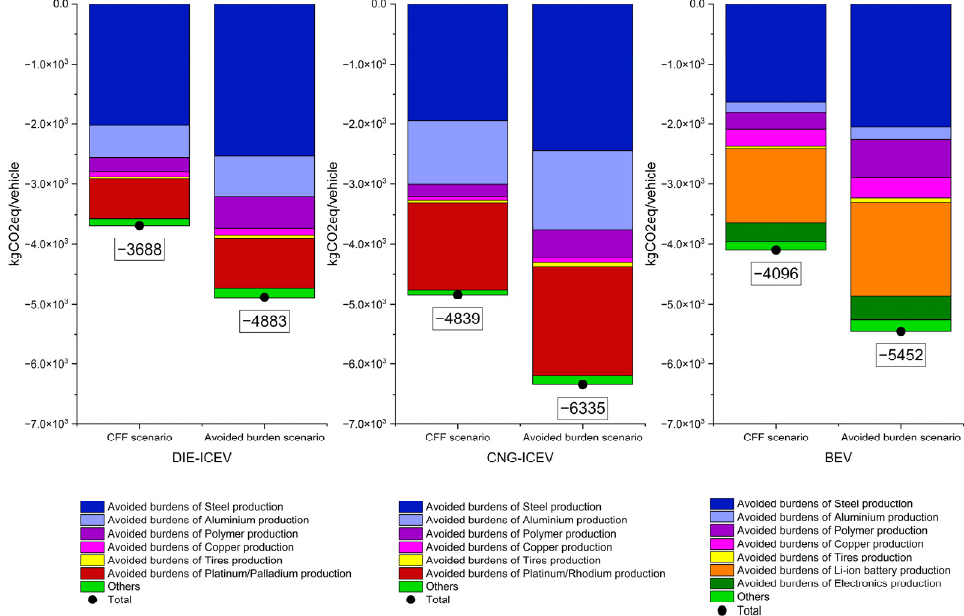
Figure 6. Avoided impacts of the two EoL scenarios studied for the three vehicle configurations.